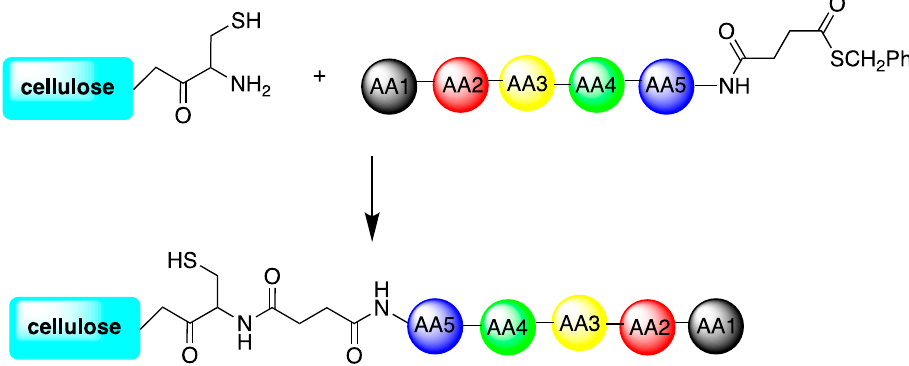
Figure 14. Summary of the Strategy used to covalently attach thioester peptides to cysteine-modified cellulose